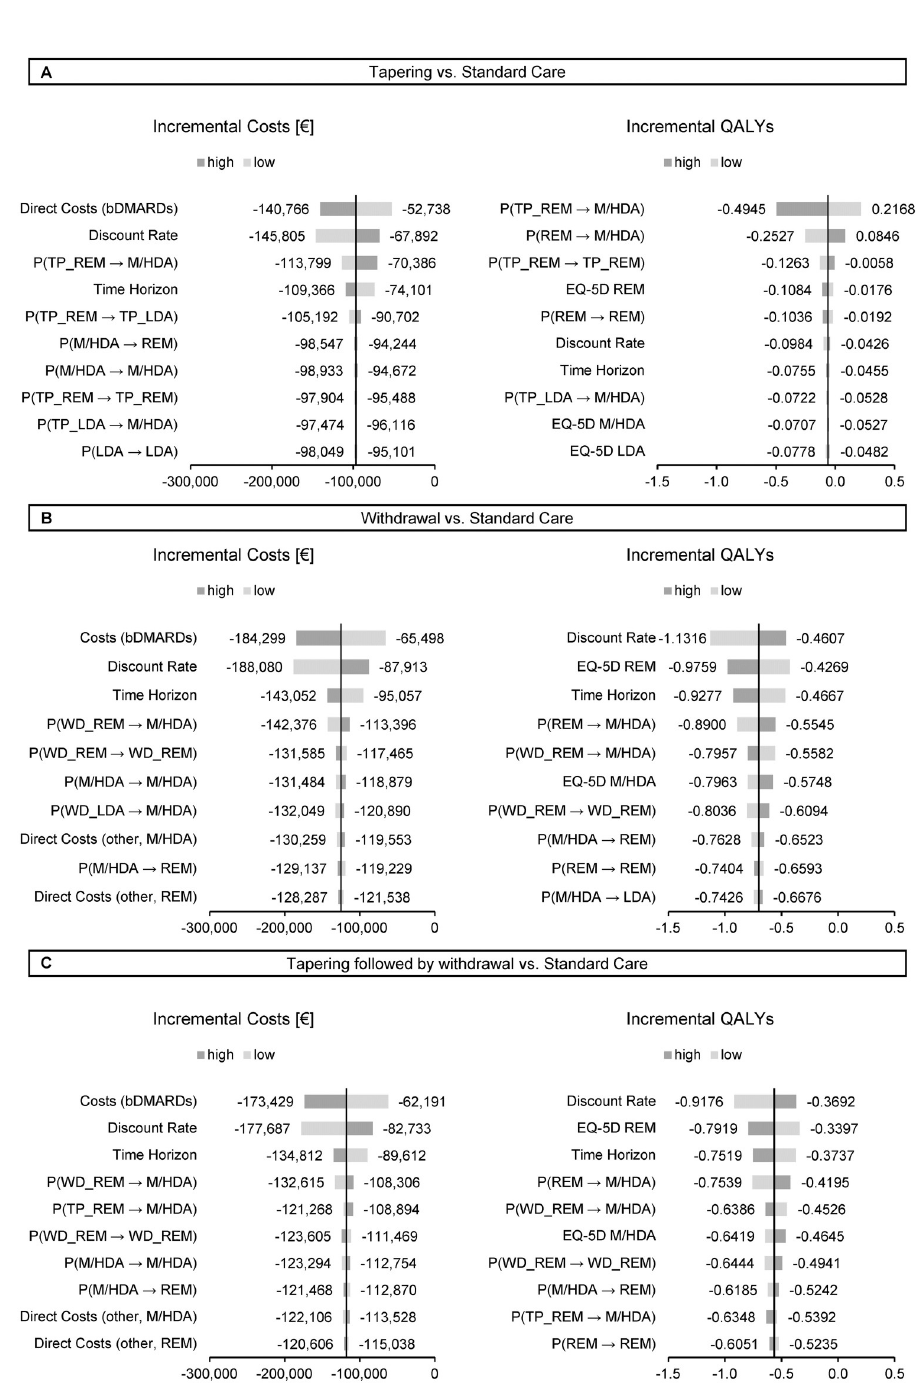
Fig 2. Results of deterministic sensitivity analyses for incremental costs and quality-adjusted life years (QALYs).